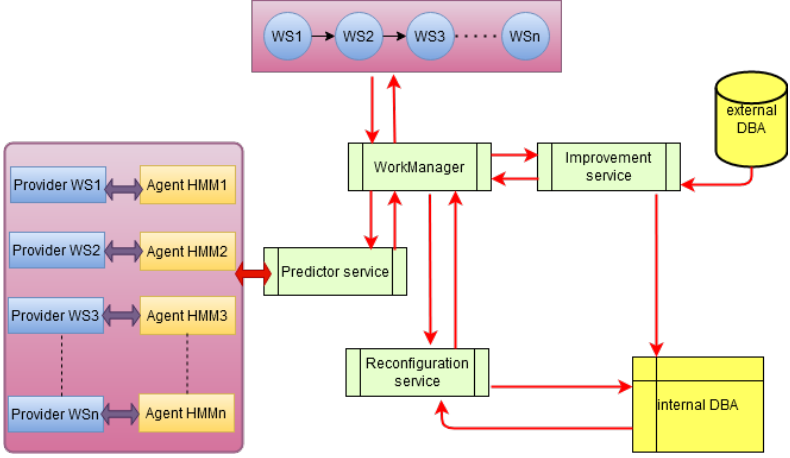
Figure 1. The proposed CWS framework